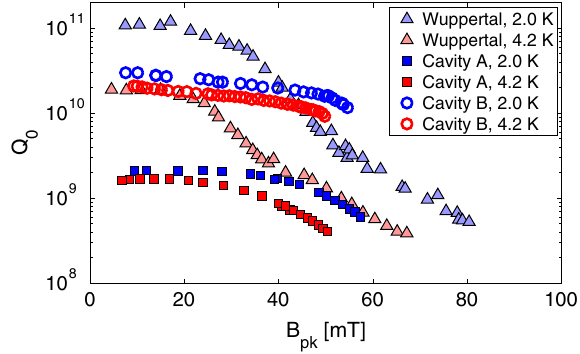
FIG. 7. RF performance curve of cavities A and B compared to the Wuppertal cavity from Fig. 2. Cavity A ’ s high R be caused by problems with the niobium substrate. Cavity B does not exhibit the strong Q -degradation observed in the other cavities. Uncertainty in Q and E is approximately 10%.